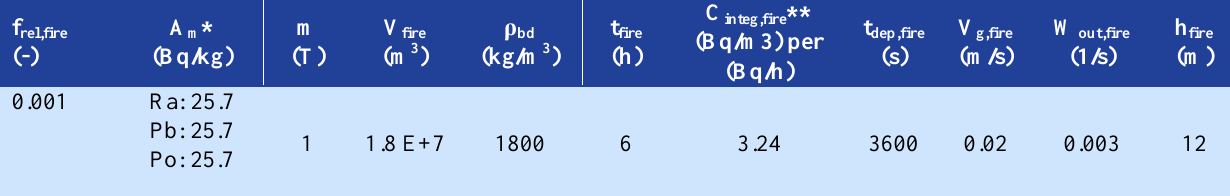
Table 1. Source term characteristics f